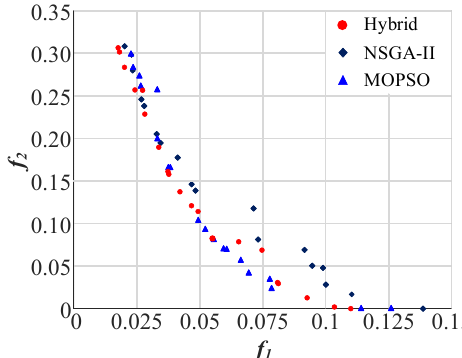
Figure 9. Comparison results of three algorithms.